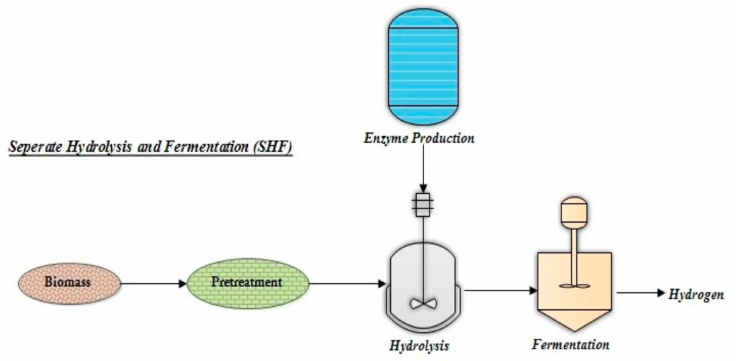
Figure 5. Schematic representation of separate hydrolysis and fermentation (SHF) for biohydro- gen production.